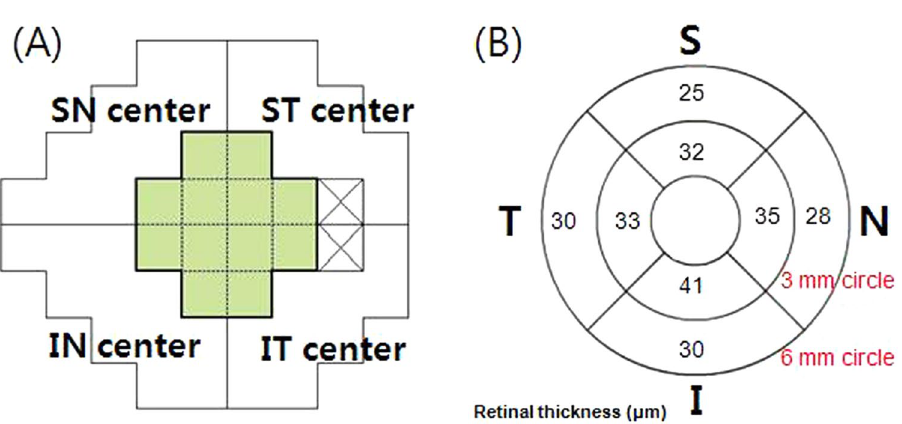
Figure 1. Divisions of the retinal layer using Spectralis SD − OCT. color-coded retinal thickness map showing mean thicknesses for each of nine subfields: scan area of 6 × 6 mm, divided into three concentric circles with 1 mm, 3 mm, and 6 mm diameter, respectively. Here, we used values from the 3 and 6 mm circles of the grid excluding a central area (1 mm radius) that corresponded to the foveola. SD-OCT, spectral-domain optical coherence tomography; RNFL = retinal nerve fiber layer; GCL = ganglion cell layer; IPL = inner plexiform layer; INL = inner nuclear layer; OPL = outer plexiform layer; ONL = outer nuclear layer.